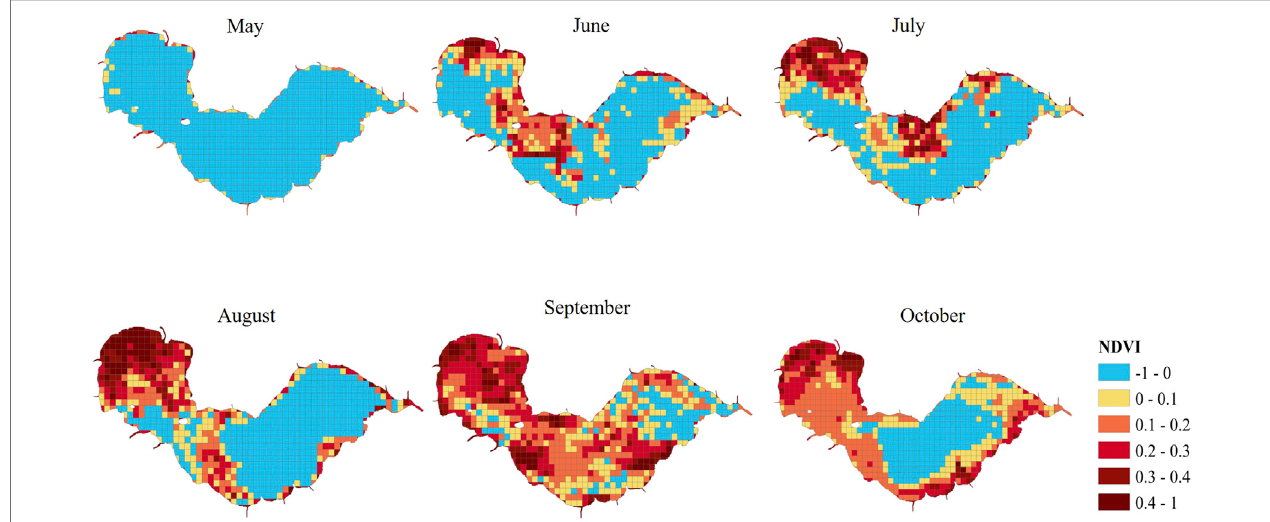
FIGURE 7 | Monthly maximum NDVI distribution of Chaohu Lake, 2011-2020.